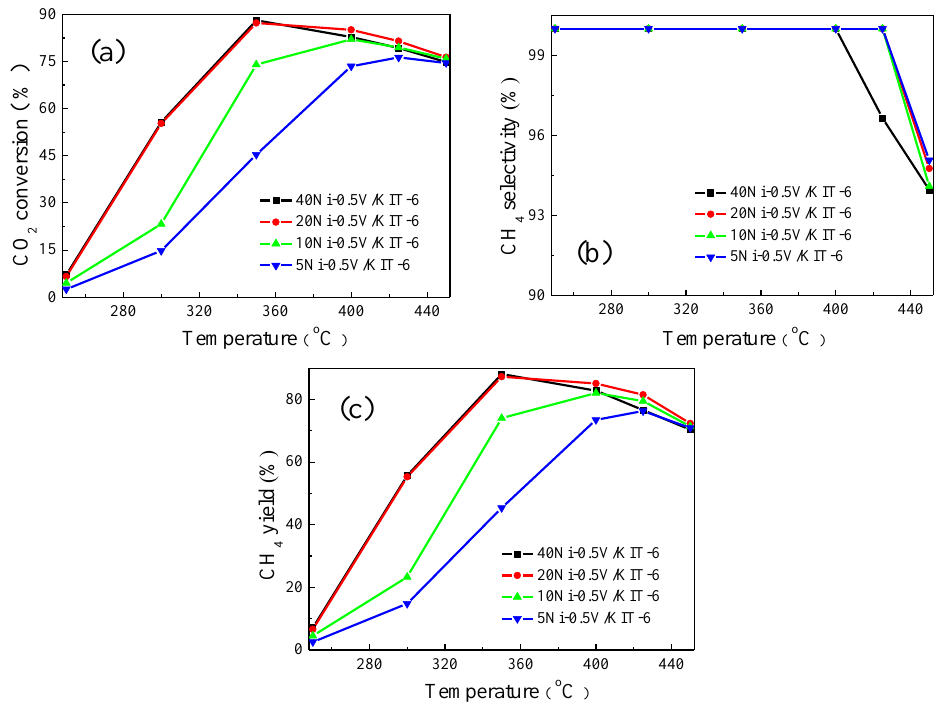
Figure 6. Catalytic performance on xNi-0.5V/KIT-6 for CO 2 methanation: ( a ) CO 2 conversion; ( b ) CH 4 selectivity and ( c ) CH 4 yield.